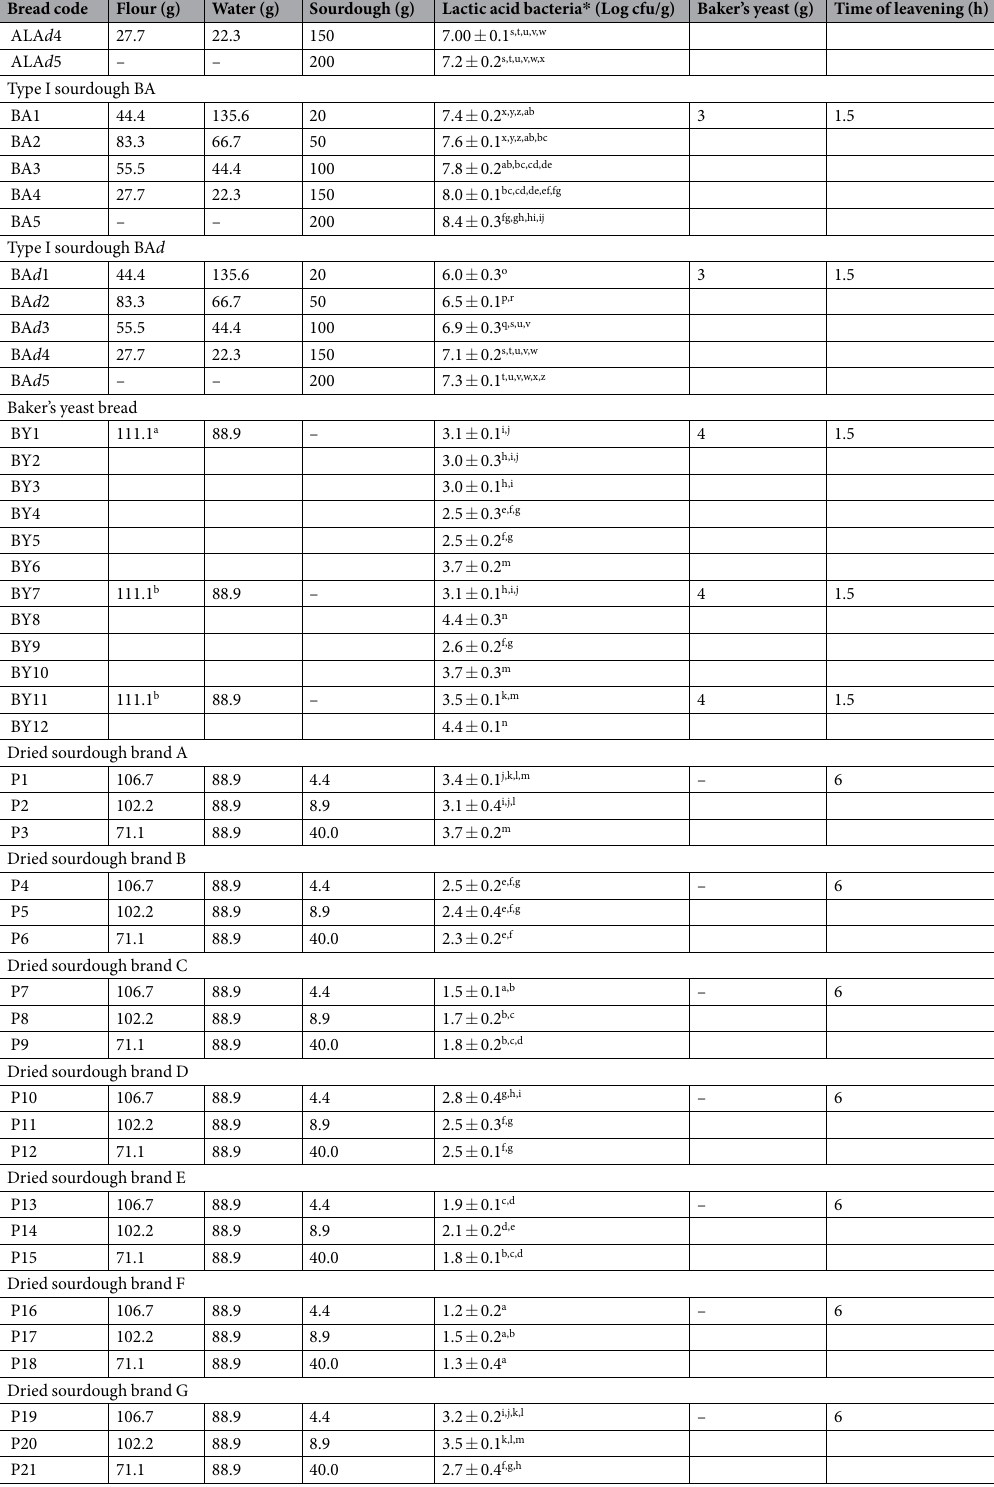
Table 2. Ingredients, technology parameters and cell density of lactic acid bacteria of traditional type I and dried sourdough or baker’s yeast breads made at the pilot plant scale. a Triticum aestivum ; b Triticum durum . * Cell density of lactic acid bacteria of the sourdough or baker’s yeast breads before the dough was subjected to baking, as estimated by plating on agar media at 30 or 37 °C for 48 h under anaerobiosis. Values are means ± standard deviation of three batches analysed in triplicate (n = 9). Values within a column with different superscript single and/or pairs letters are significantly different (P <